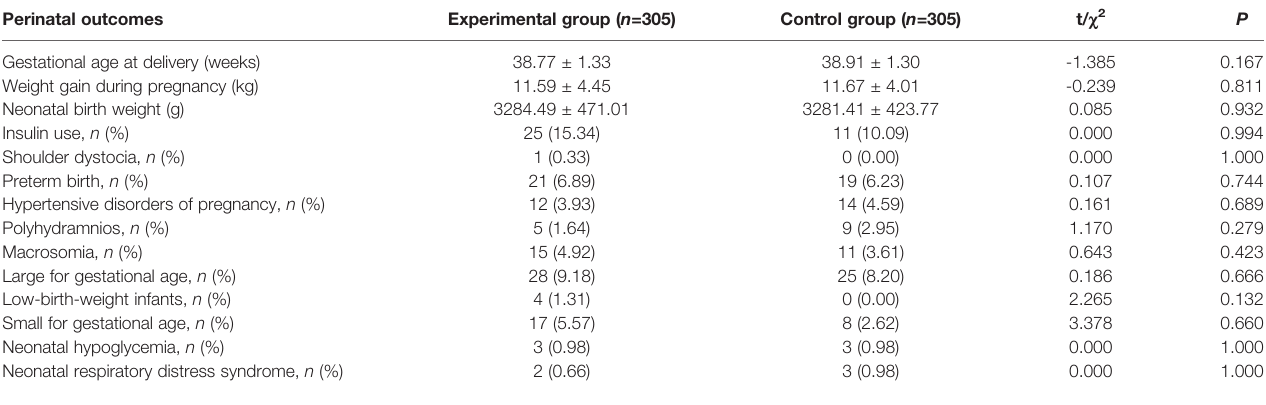
TABLE 5 | Comparison of perinatal outcomes between the experimental and control groups. Perinatal outcomes